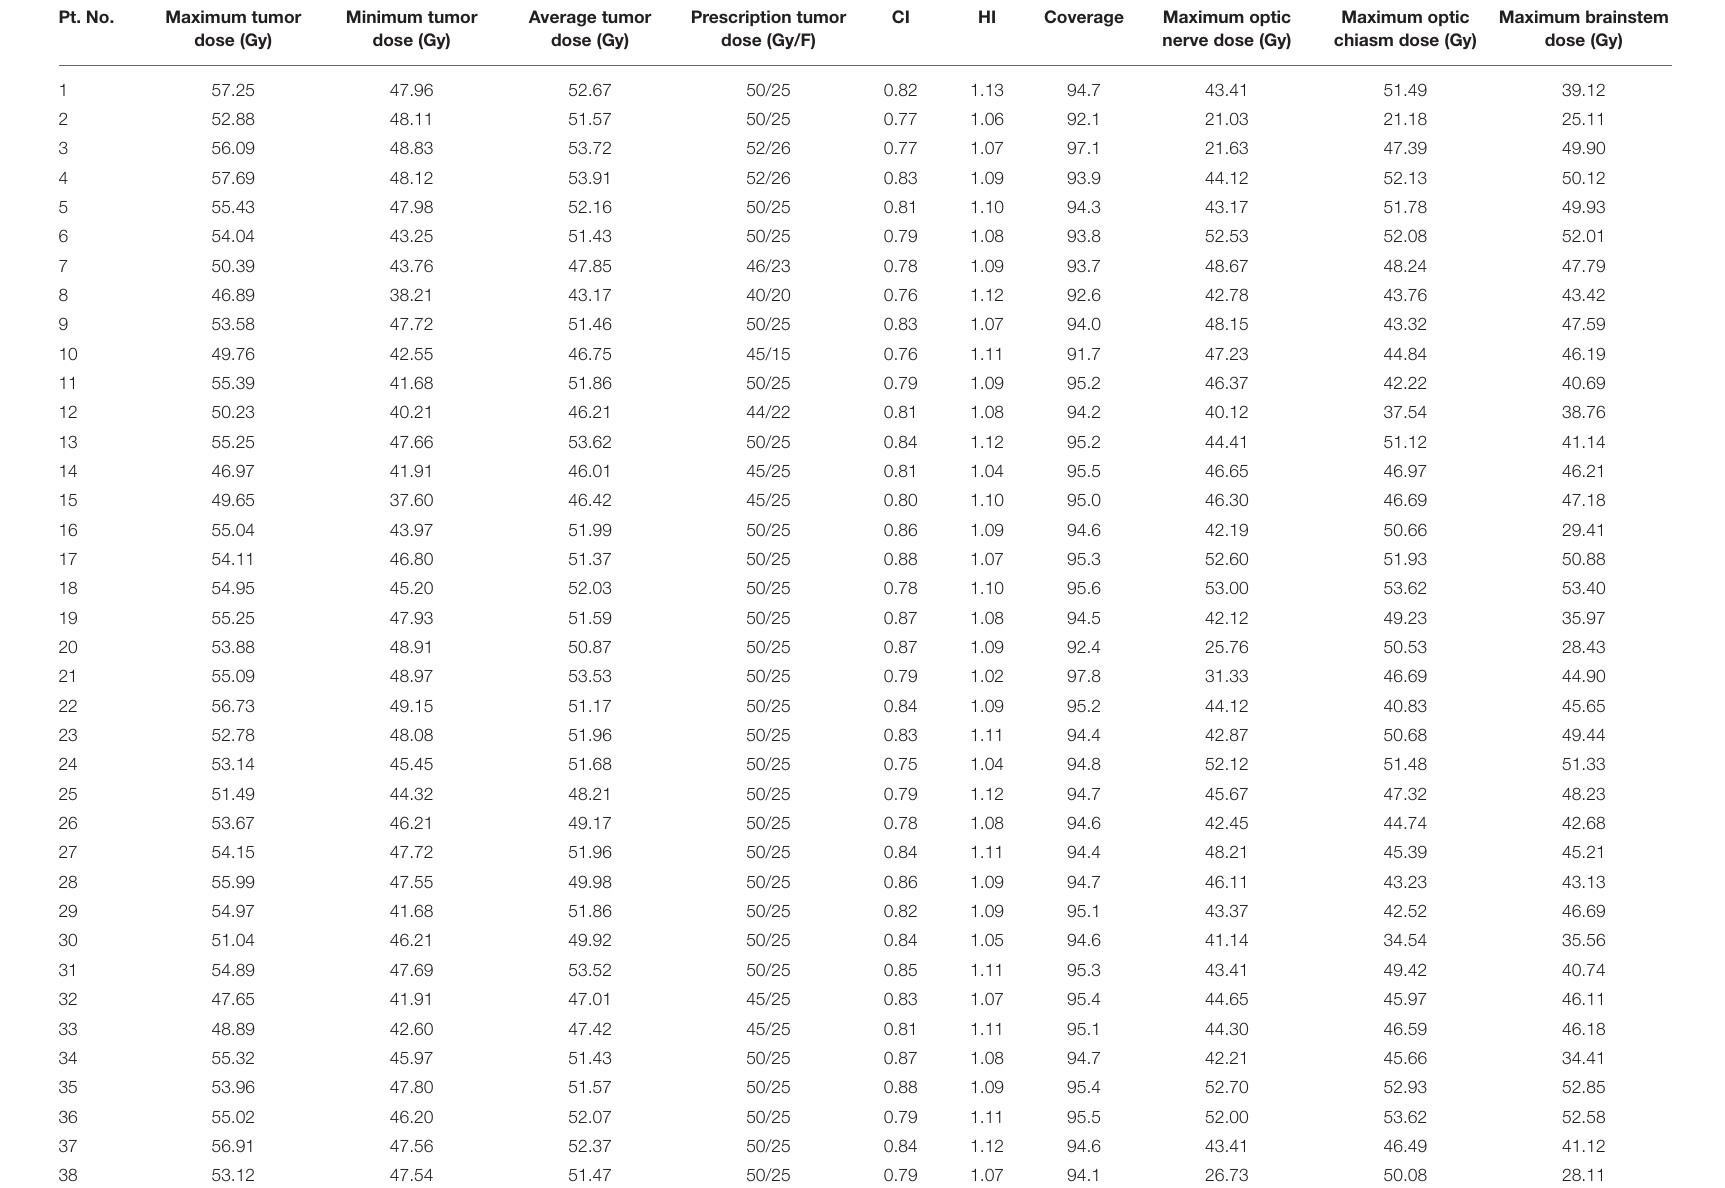
TABLE 2 | Treatment characteristics and dose volume analyses of 54 patients. Pt.